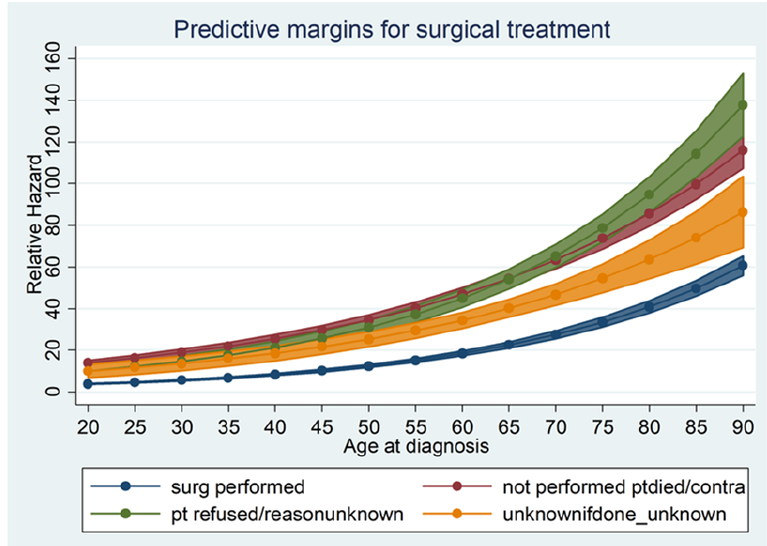
Figure 2. Relative Hazard (RH) of death as a nonlinear function of age at diagnosis, stratified for surgical intervention and non-surgical intervention. The RH is adjusted for other confounders. RH determined from overall survival (OS). Surg performed = those who had surgical intervention; Pt refused/reason unknown = patient refused or no reason given; not performed pt died/contra = no surgery performed or patient died; Unknownifdone_unknown = unknown if surgery was